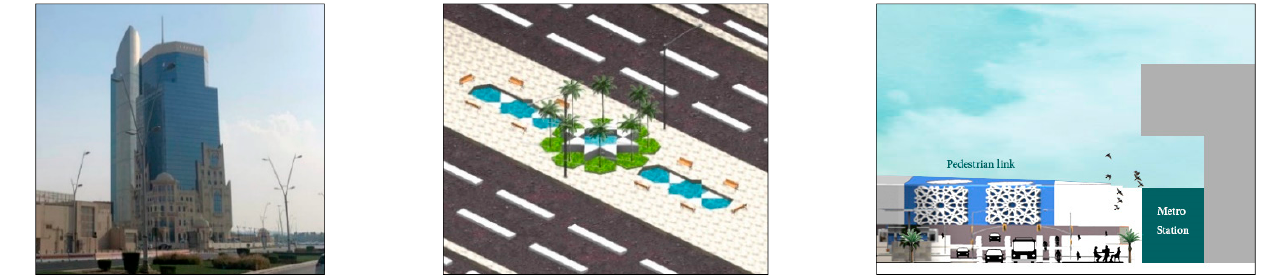
Figure 30. ( left ) Ezdan Tower; ( middle ) proposed use of Islamic patterning on vegetation box and fountain; ( right ) use of Islamic patterning on a metro pedestrian link (Source: the Authors).